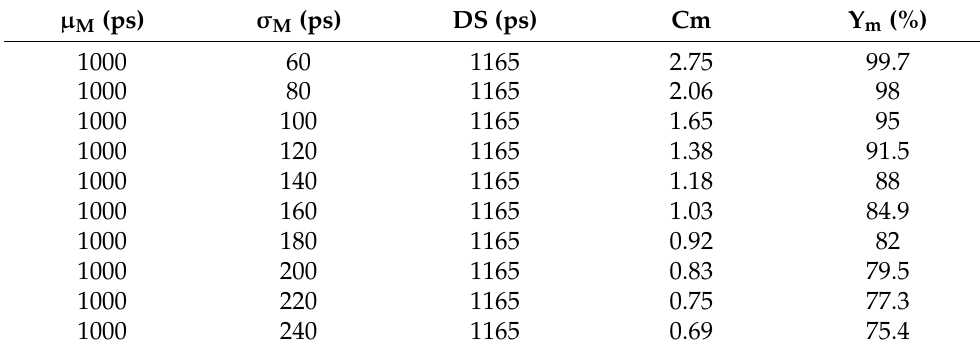
Figure 3. Impact of semiconductor manufacturing process changes on manufacturing yield. Table 1. The relationship between process changes and manufacturing yield.